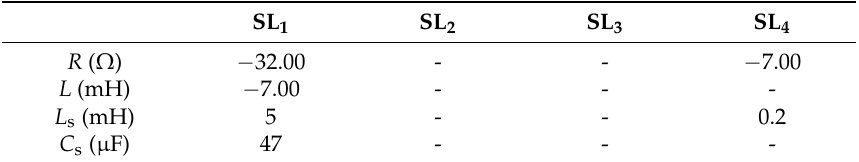
Table 7. Shunt circuit parameters used in the experiment of the shunted loudspeaker (SL) array.